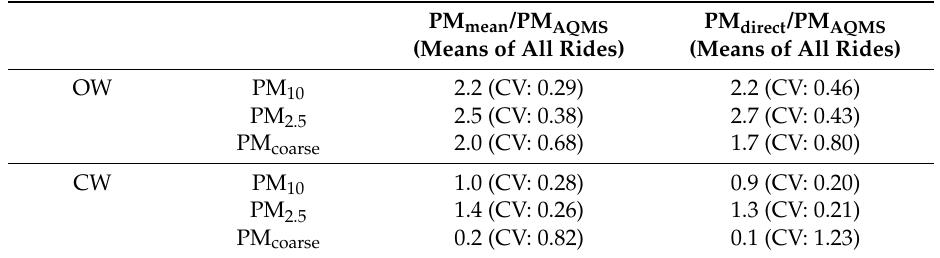
Table 5. Mean PM mean /PM AQMS -and PM direct /PM AQMS -quotients of all rides on the circular drive. PM mean /PM AQMS PM direct /PM AQMS (Means of All Rides) (Means of All Rides) OW PM 10 2.2 (CV: